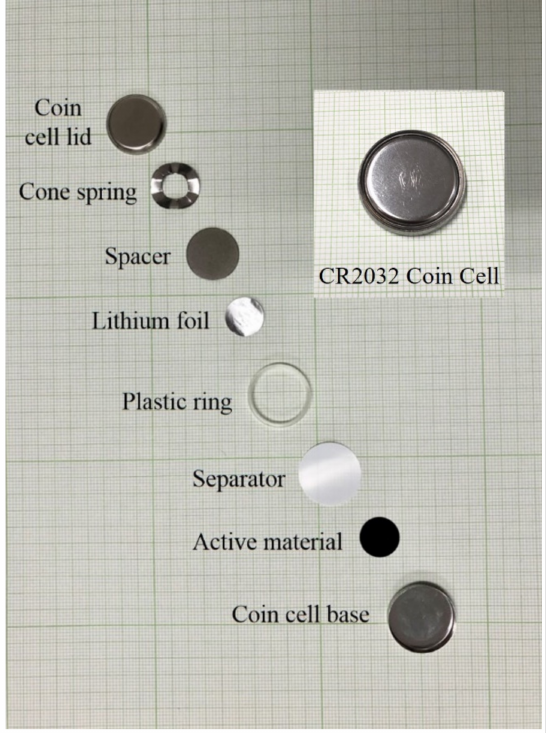
Figure 1. The component of the testing LIB coin